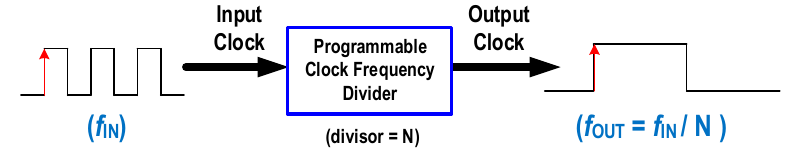
Figure 5. Operation of a general programmable clock frequency divider.